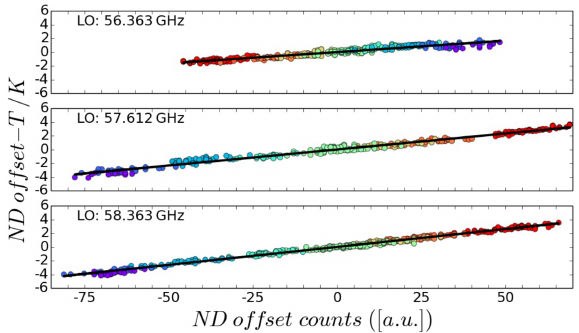
Figure 9. Calculated ND offset temperature for occurring ND count offsets (for better comparability, the means of the temperature and count values have been removed – mean values are shown in Ta- ble 4). Color coding is as follows. For the MTP scanning unit tem- perature blue indicates colder and red warmer; black line: linear fit linking ND offset temperature to offset